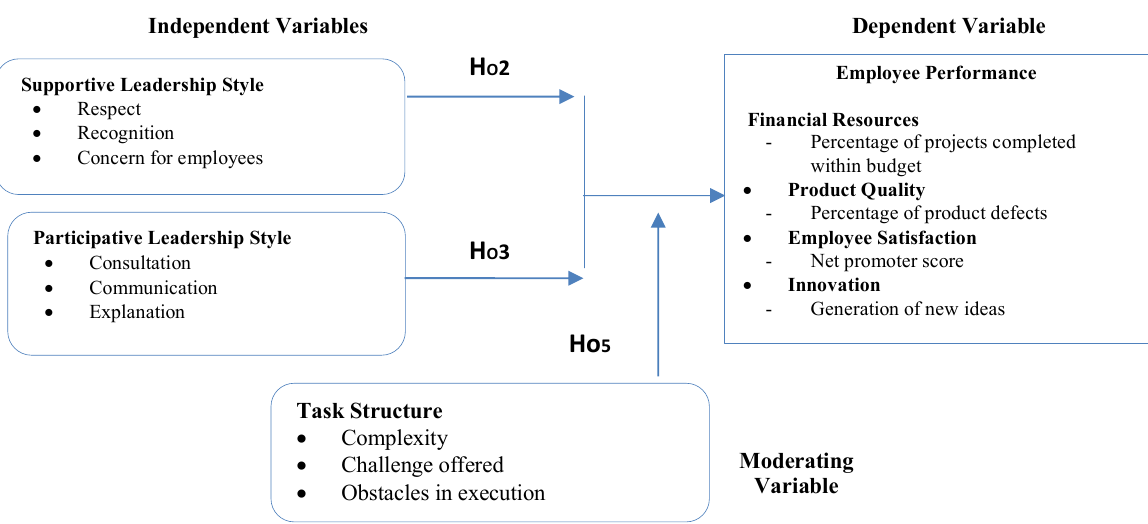
Figure 1: Conceptual